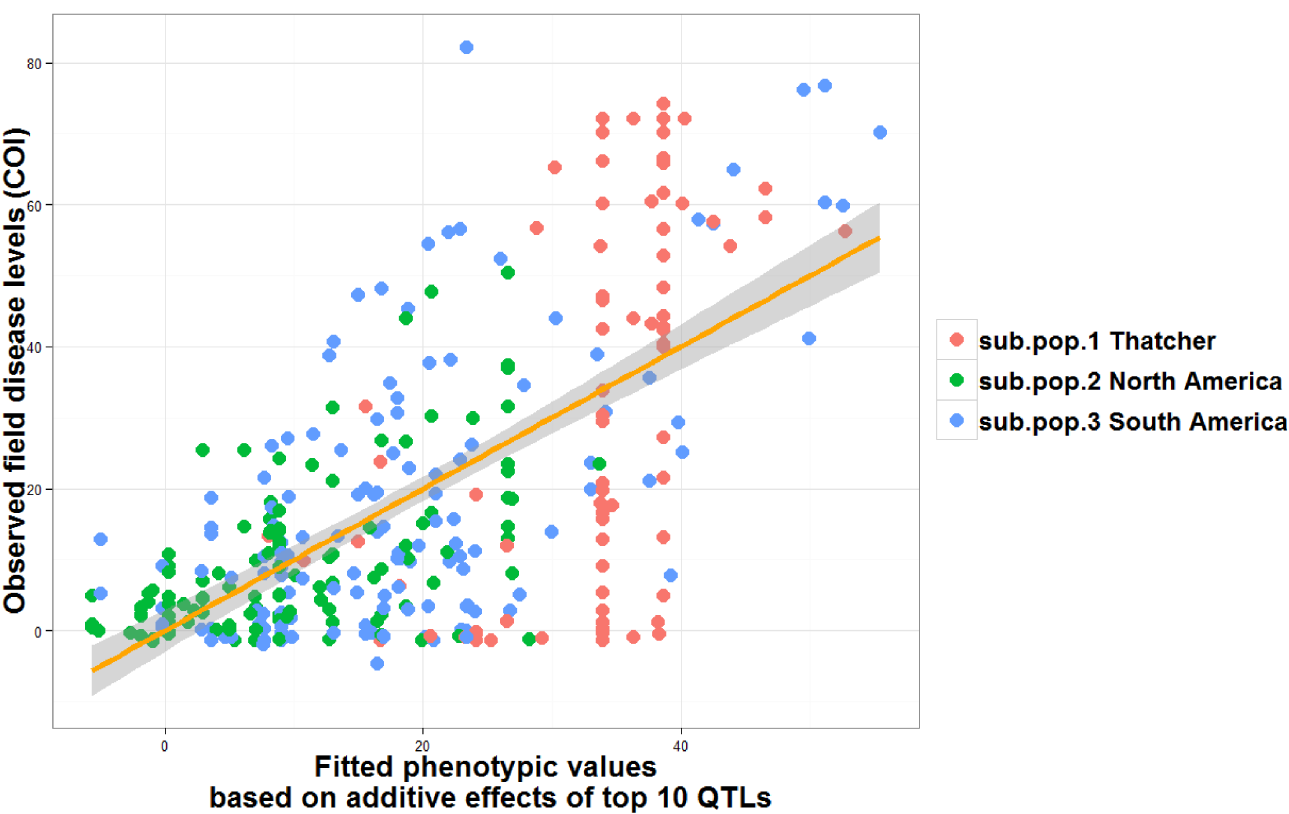
Fig 7. Scatterplot of phenotypic values versus genotypic fitted values using markers representing top ten QTLs for field resistance.